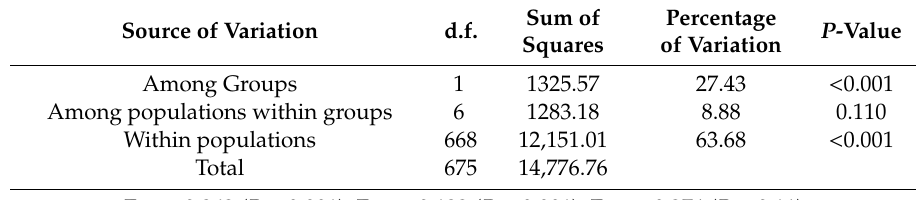
Sum of Percentage P -Value Squares of Variation